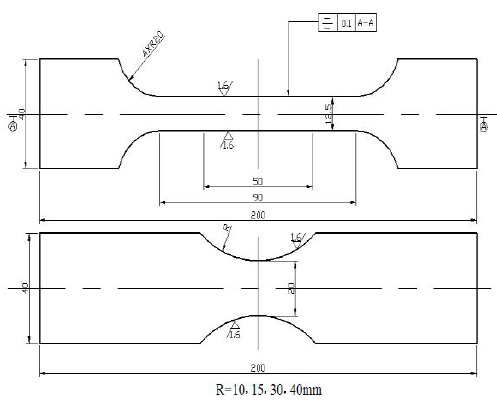
Figure 4. Size of samples with different strain paths.